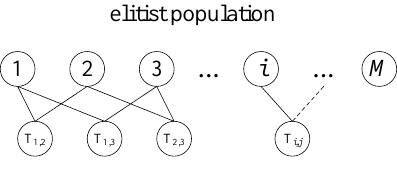
Fig. 4 Binary Differential